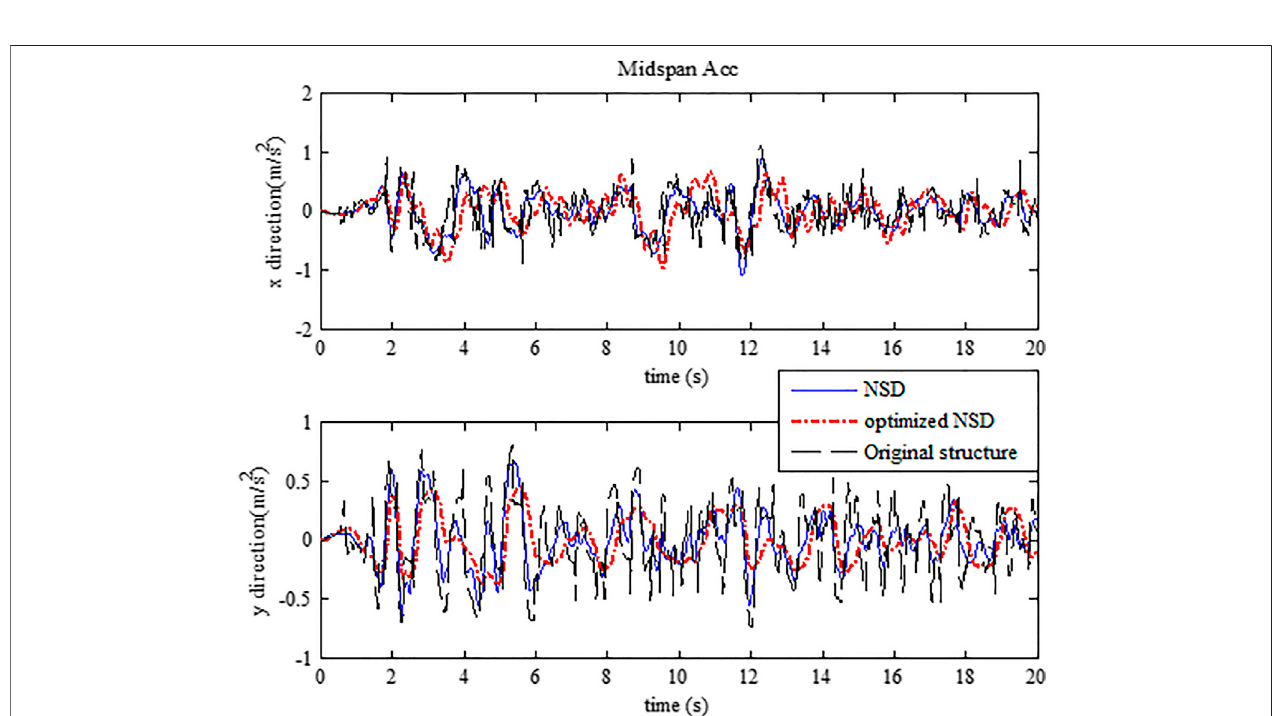
FIGURE 5 | Time history of acceleration responses at mid-span under El Centro earthquake.